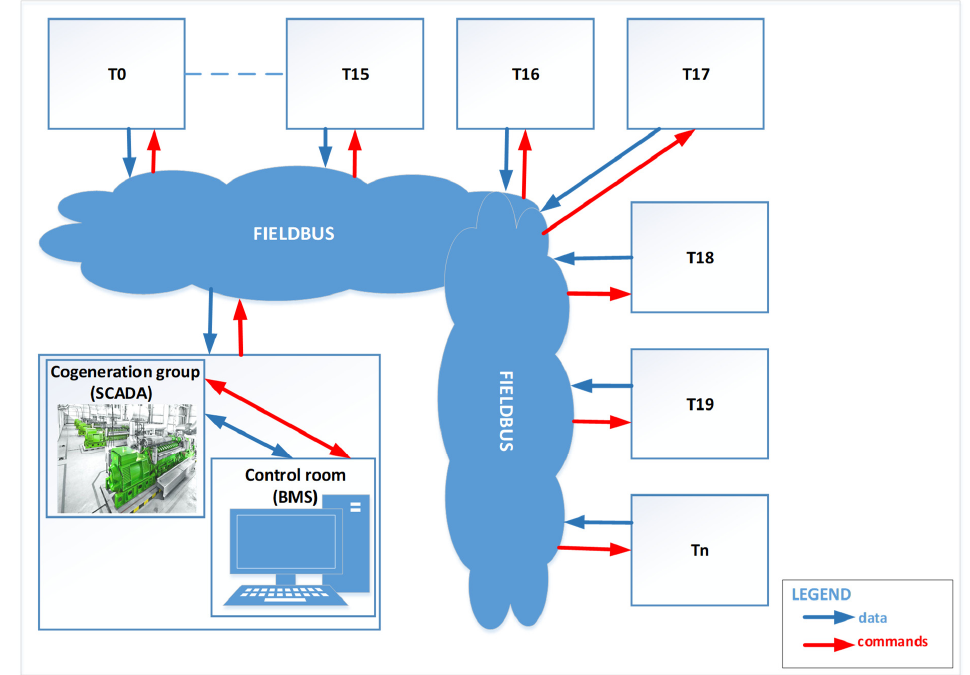
Figure 1. Data and command transmission